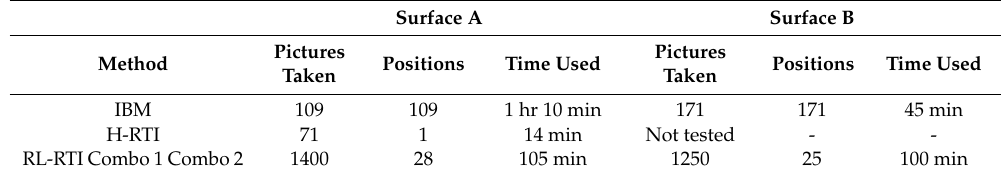
Table 1. The table illustrates the on-site time-e ffi ciency of each method on each recorded surface. In general, Reflective Transformation Imaging (RTI) image acquisition is faster than Imaged-Based Modelling (IBM) image acquisition. However, when used for larger surfaces with the intention of combining the results, using Rigged Light RTI (RL-RTI) requires photographing from many positions with a lot of overlap—making the combination methods slower on-site.